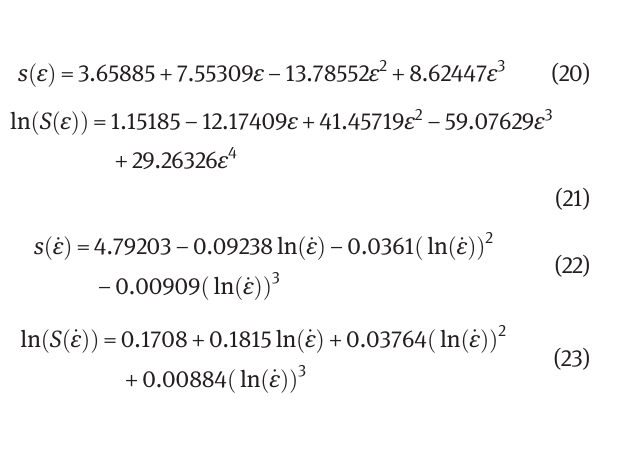
Figure 7: Relationship between (a) n ( ε )- ε ; and (b) ln( N ( ε ))- ε .